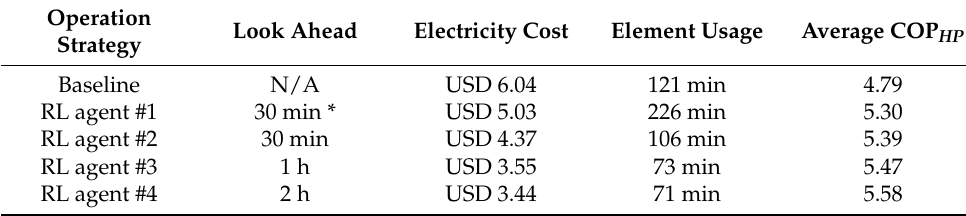
Table 5. Comparison of baseline and